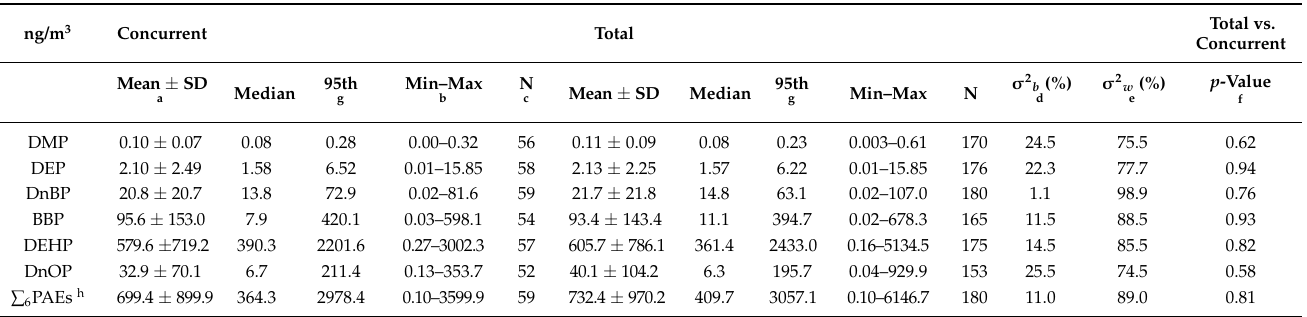
Table 1. Summary statistics of individual PAE congeners and ∑ 6 PAEs (ng/m 3 ) in personal PM 2.5 samples from study